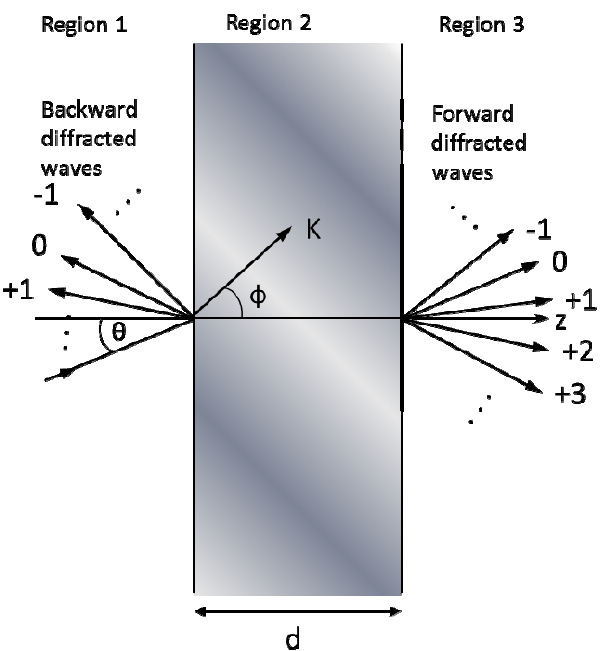
Figure 20. Geometry for planar-grating diffraction. Region 1 ( left ) is the region of incident light, which will contain both incident and reflected waves. Region 2 ( middle ) is the transmission grating, which will contain transmitted and reflected waves. Region 2 ( right ) is the substrate, which will contain only forward diffracted (transmitted) waves. This example uses a simple transmission grating with a sinusoidal permittivity that is oriented at an arbitrary angle from